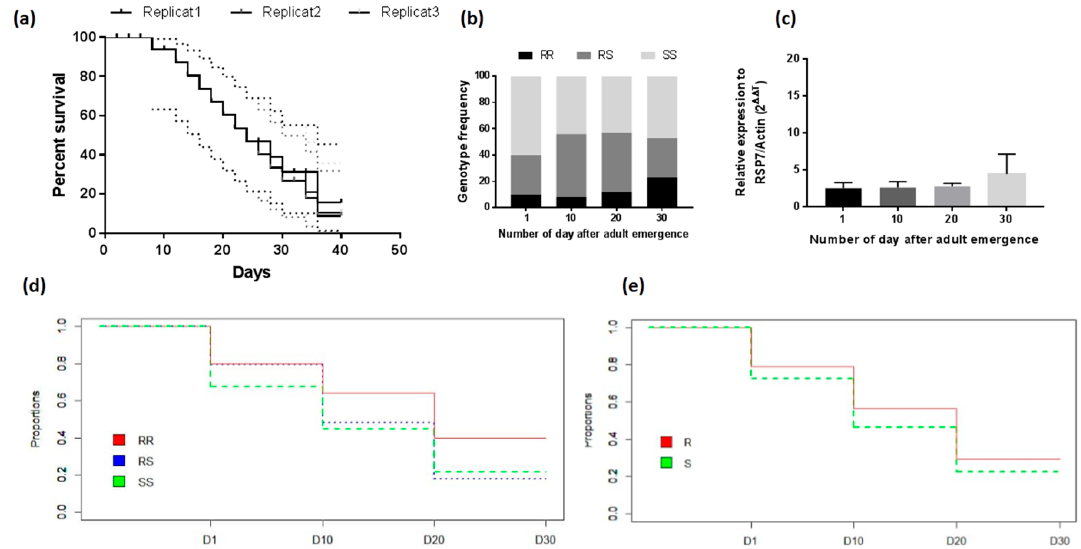
Figure 3. Influence of L119F-GSTe2 on the adult longevity of An. funestus . ( a ) Survival curve F1of adults from natural populations and maintained under laboratory conditions: Mean percentage of mortality and 95% confidence interval (CI) were presented; ( b ) distribution of L119F-GSTe2 genotypes at different time in the survived mosquitoes; ( c ) differential expression by quantitative reverse-transcription polymerase chain reaction of GSTe2 genes in alive mosquitoes at different time points compared with the susceptible lab strain FANG. Error bars represent standard error of the mean; ( d , e ) Variation in the proportion of adults surviving at the different time points after the emergence into adult according to the L119F genotypes and alleles respectively. Table 3. Association between L119F-GSTe2 genotypes and adult longevity.